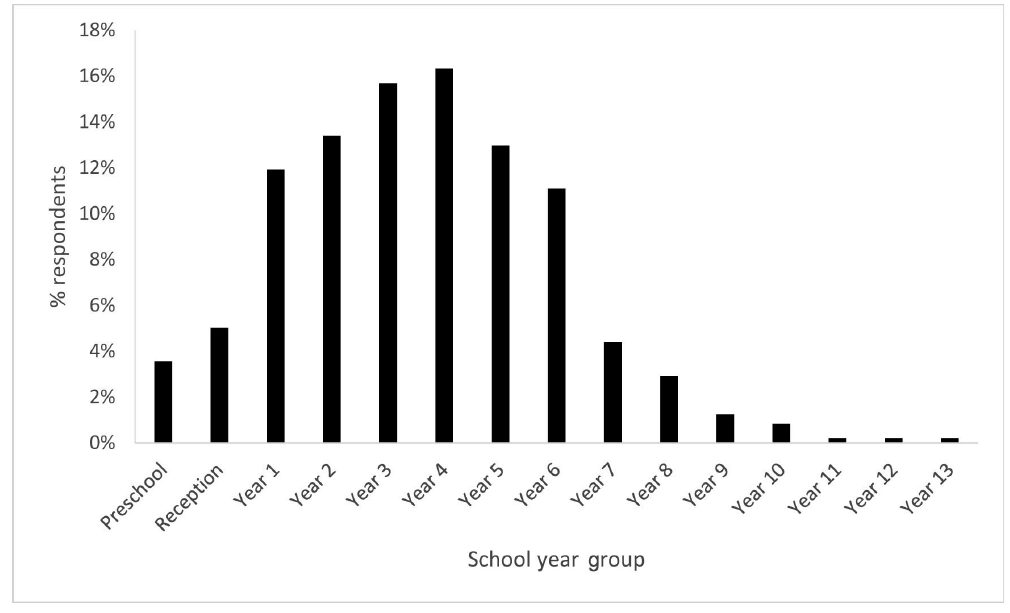
Figure 7: School year groups of 478 children attending Science Hunters public events at Lancaster University Community Day (2017), Lancashire Science Festival (2017), Lakeland Wildlife Oasis (2018), Geronimo Children’s Festival (2018) and Lancashire Science Festival (2018), where demographic information was collected from a combined total of 35 per cent of attending